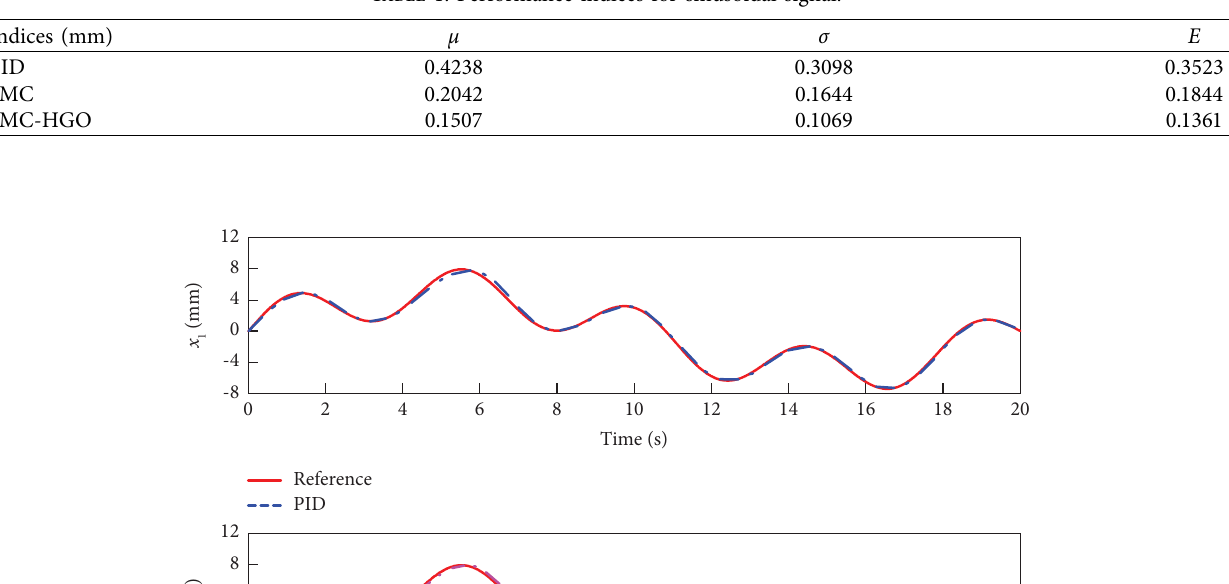
Table 1: Performance indices for sinusoidal signal.